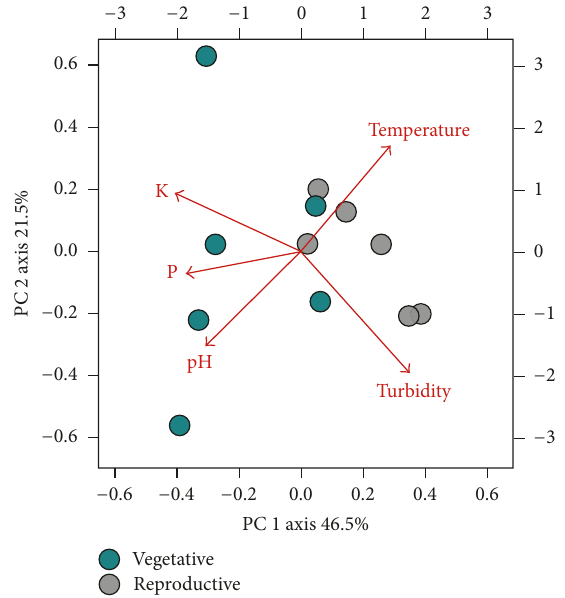
Figure 2: PCA biplot of physical and chemical parameters sampled from rice floodwaters from vegetative and reproductive